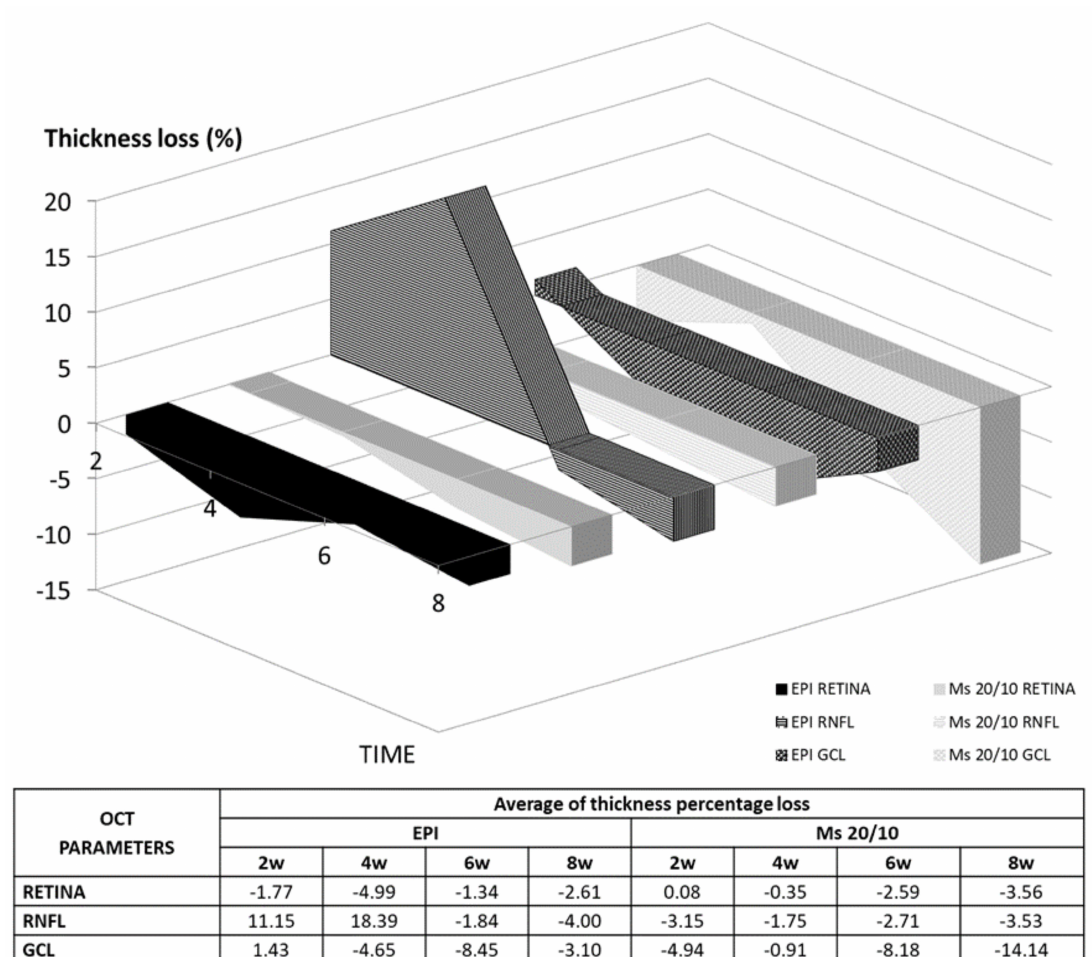
Figure 6. Changes in thickness percentage loss measured by optical coherence tomography (OCT) in two ocular hypertensive (OHT) models. Abbreviations: EPI: episcleral sclerosis model; Ms20/10: 20/10 microsphere model; RNFL: retina nerve fiber layer; GCL: ganglion cell layer complex; w: week; %: